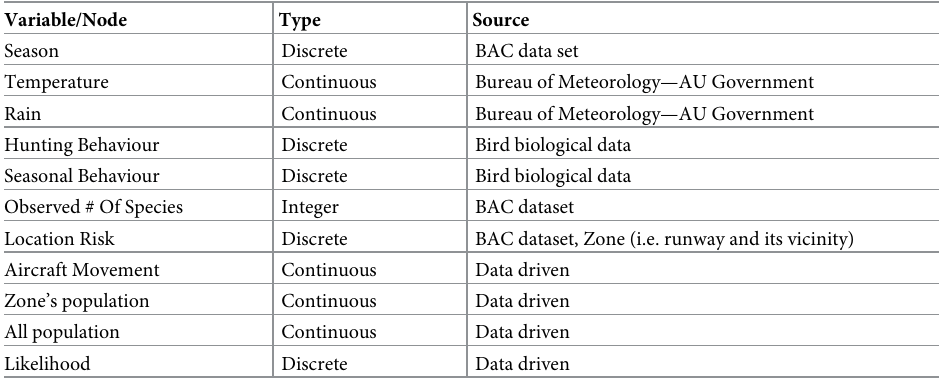
Table 2. Identified data sources and their description of these variables.